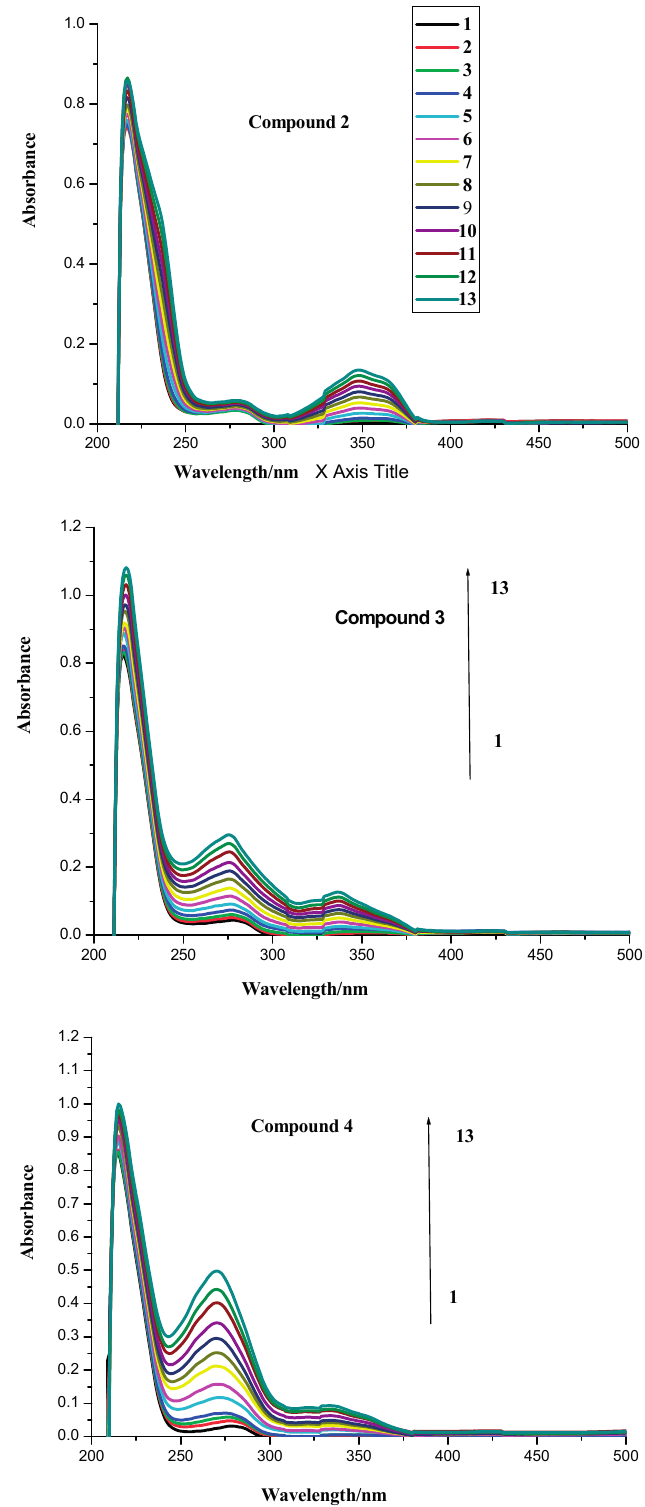
Figure 3. UV absorption spectra of compounds 1 – 4 with BSA. Numbers 1–13 indicated the concentrations of compounds 1 – 4 : 0.0, 0.4 × 10 − 6 , 0.8 × 10 − 6 , 1.2 × 10 − 6 , 2.4 × 10 − 6 , 3.6 × 10 − 6 , 4.8 × 10 − 6 , 6.0 × 10 − 6 , 7.2 × 10 − 6 , 8.4 × 10 − 6 , 9.6 × 10 − 6 , 10.8 × 10 − 6 and 12 × 10 − 6 mol·L − 1 , respectively. BSA concentration applied was 1.04 × 10 − 6 mol·L − 1